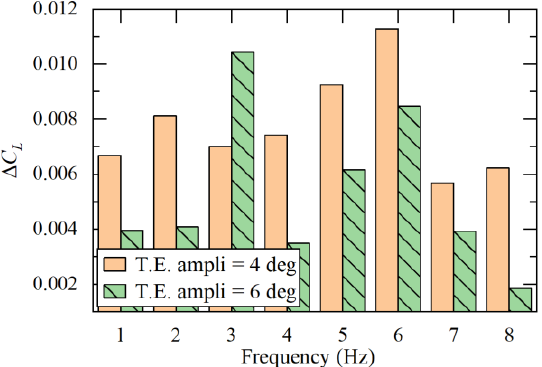
Figure 28. Effect of trailing edge vibration on force measurement without